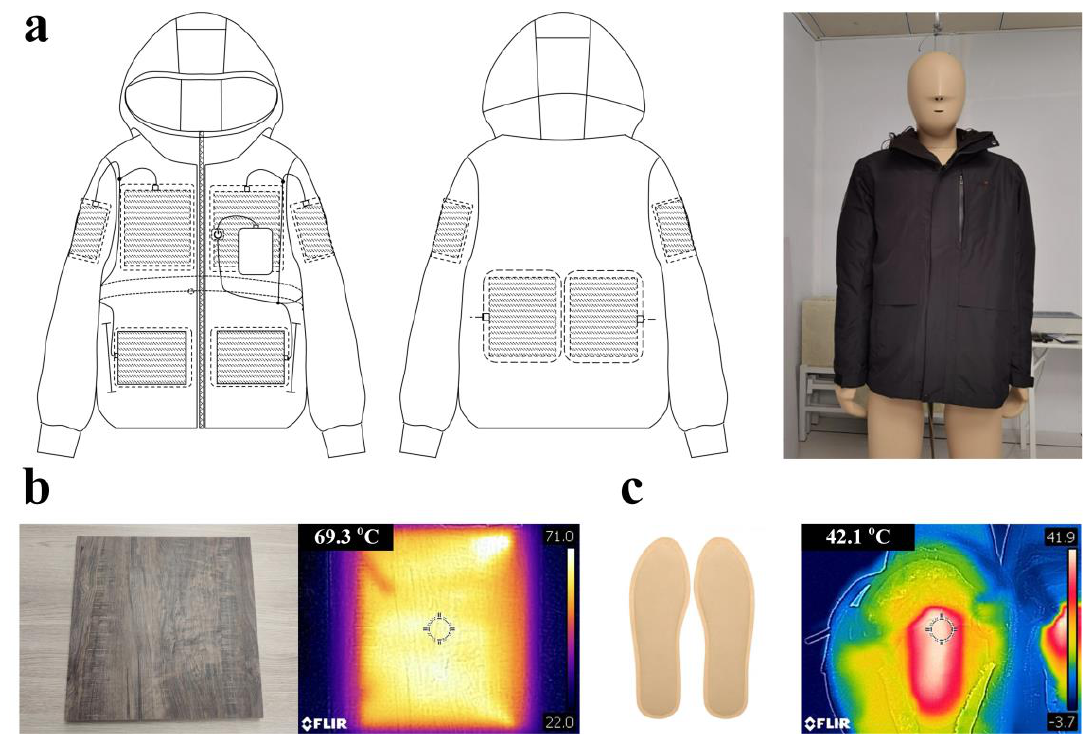
Figure 3. Personal heating devices: ( a ) EHG, ( b ) EHS, and ( c ) CHI.